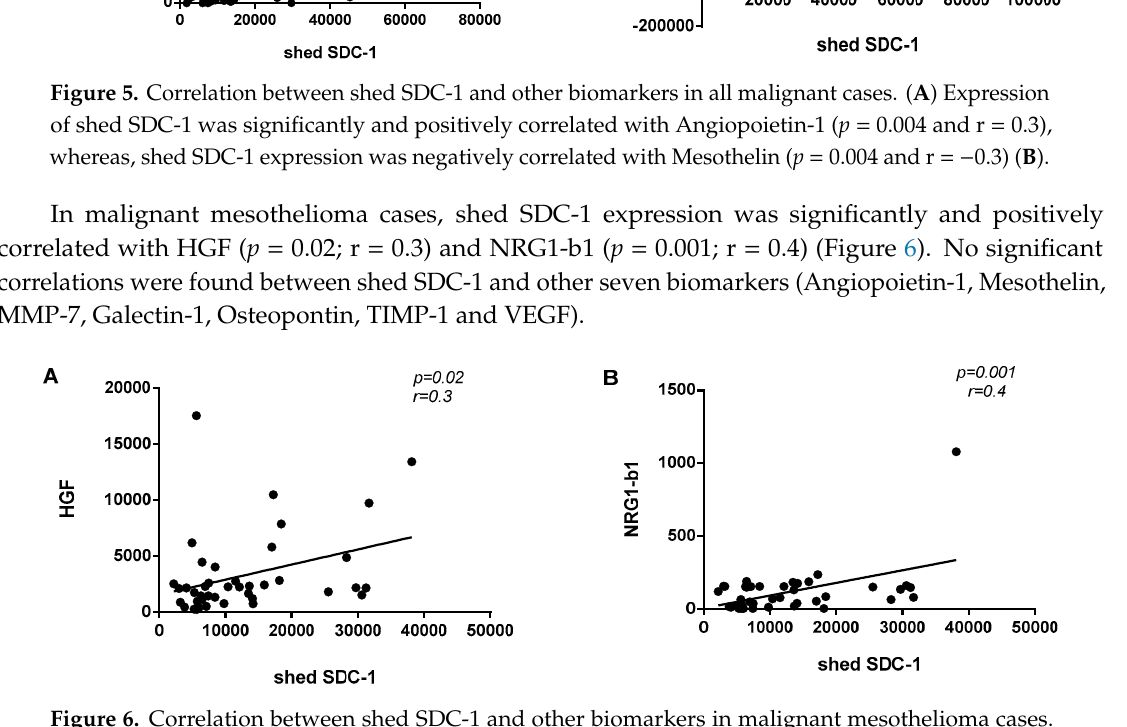
Figure 6. Correlation between shed SDC-1 and other biomarkers in malignant mesothelioma cases. ( A ) Expression of shed SDC-1 was significantly and positively correlated with HGF ( p = 0.02 and r = 0.3) and NRG1- β 1 ( p = 0.001 and r = 0.4) ( B ) in malignant mesothelioma cases.